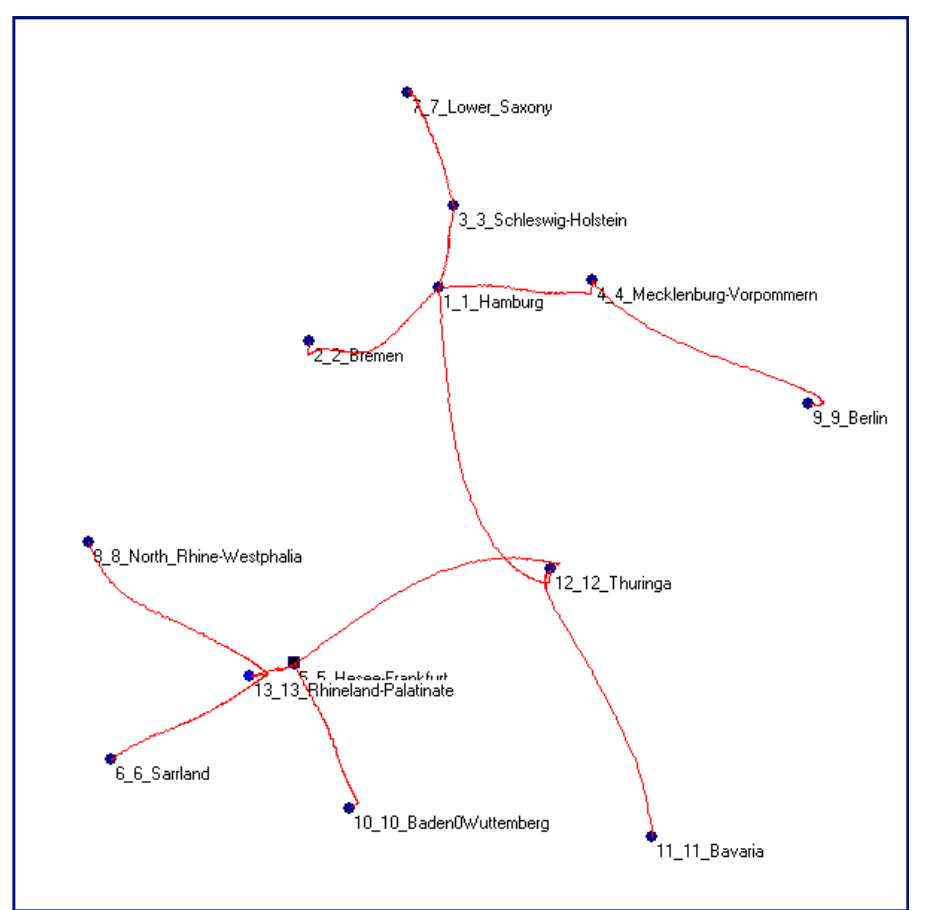
Figure 16. The Diffusion Paths rebuilt by the TWC- γ